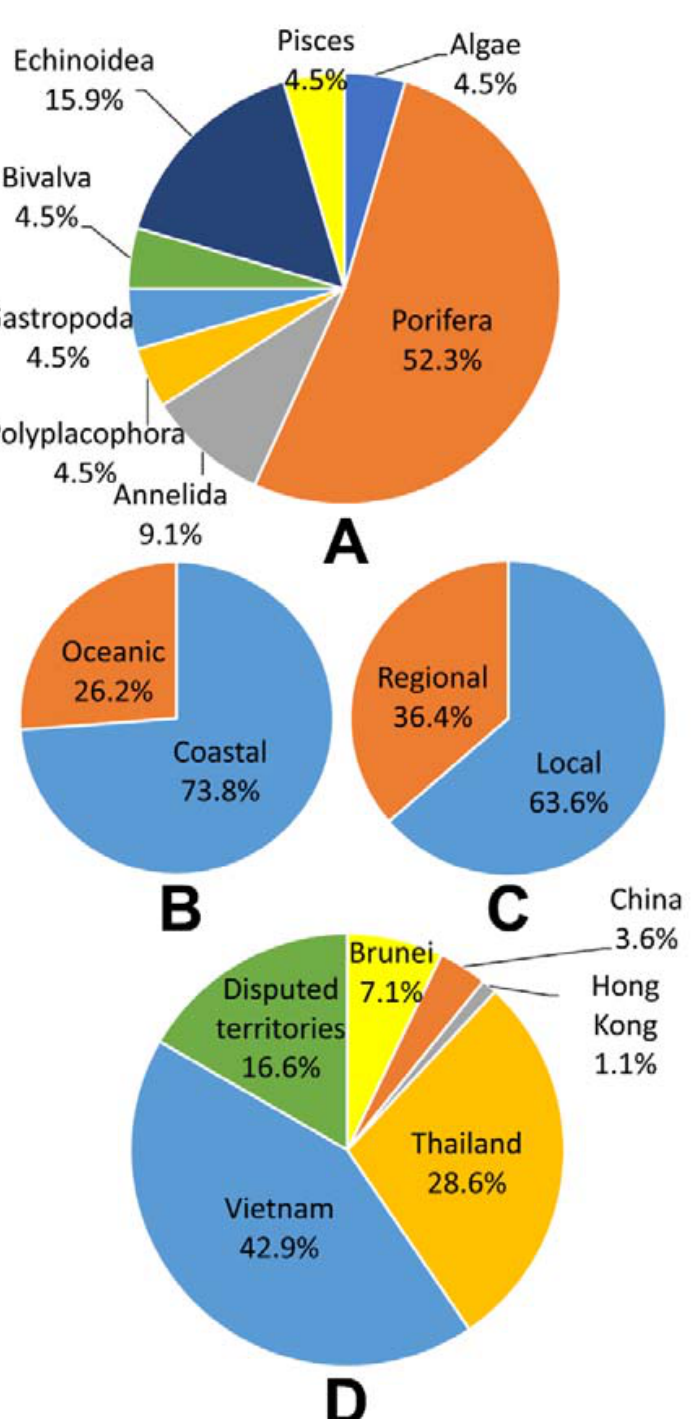
Figure 5. Proportional publications with faunistic checklists recording bioeroders in the South China Sea. ( A ) Taxon groups (n = 22). ( B ) Closeness of study location to mainland (n = 14; cutoff at 12 nautical miles). ( C ) Scale of research area, with regional (South China Sea) or local studies (within one country; n = 22). ( D ) Local faunistic checklists for sites within different countries (n = 14). For the checklists, the research locations can be divided by distance to the mainland into coastal (74%) and oceanic studies (26%). We based the decision for the former within 12 nautical miles of territorial waters (1982 United Nations Convention on the Law